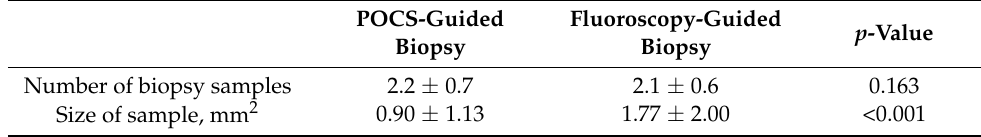
Table 3. Number and size of POCS-guided and fluoroscopy-guided biopsy samples.